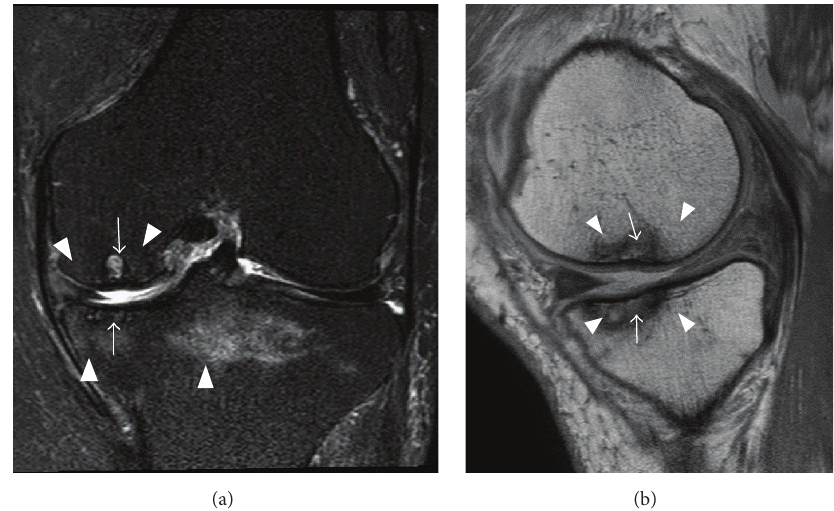
Figure 3: MRI 4 months after first evaluation. (a) Coronal SPIR and (b) sagittal proton density-weighted images showed persistent focal SPONK lesions of both the MFC and the MTP, but the surrounding bone edema had decreased